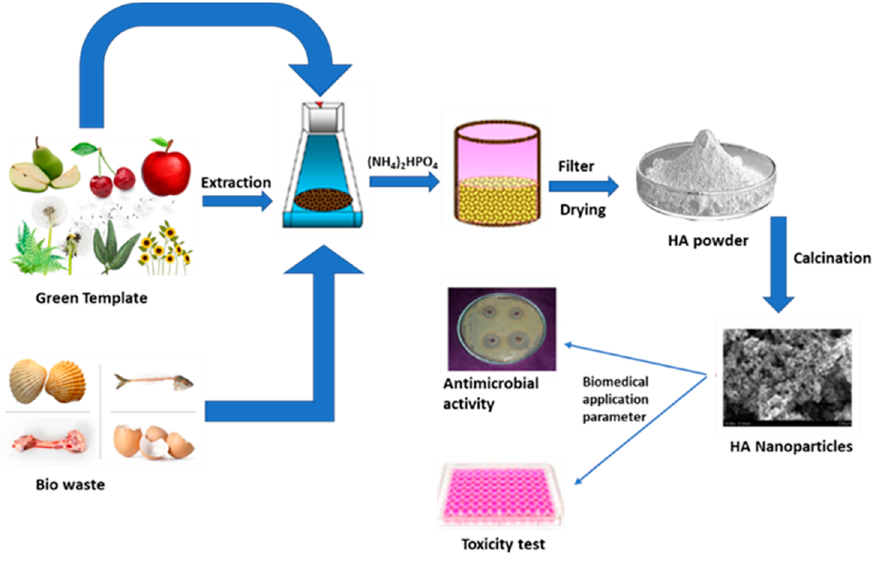
Figure 5. The procedure of formation of HA nanoparticles with a green template adapted from [24,25].